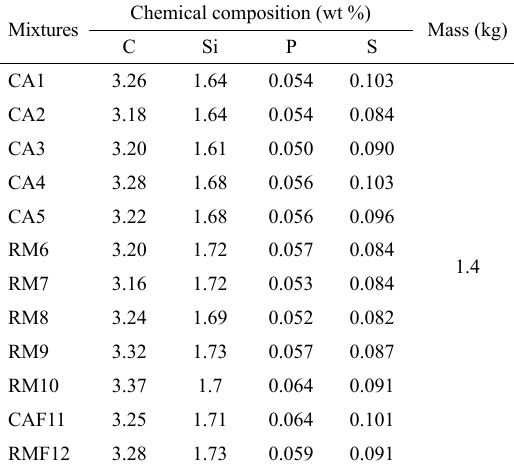
Table 3. Chemical components used on the production of synthetic slags.